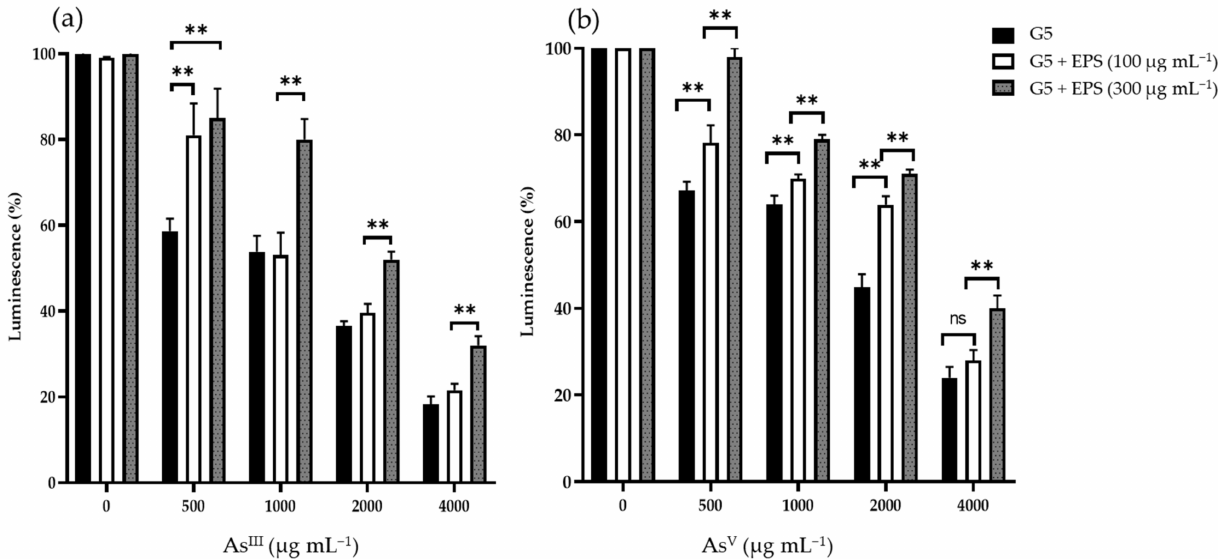
Figure 4. ( a ) As III or ( b ) As V toxicity expressed as a percentage of luminescence emitted by V. harveyi G5 (G5) after 15 min of incubation in the presence of EPS at two different concentrations (100 or 300 µ g mL − 1 ). Not significantly different (ns) * Significantly different by ANOVA ( p ≤ 0.05) and ** ( p ≤